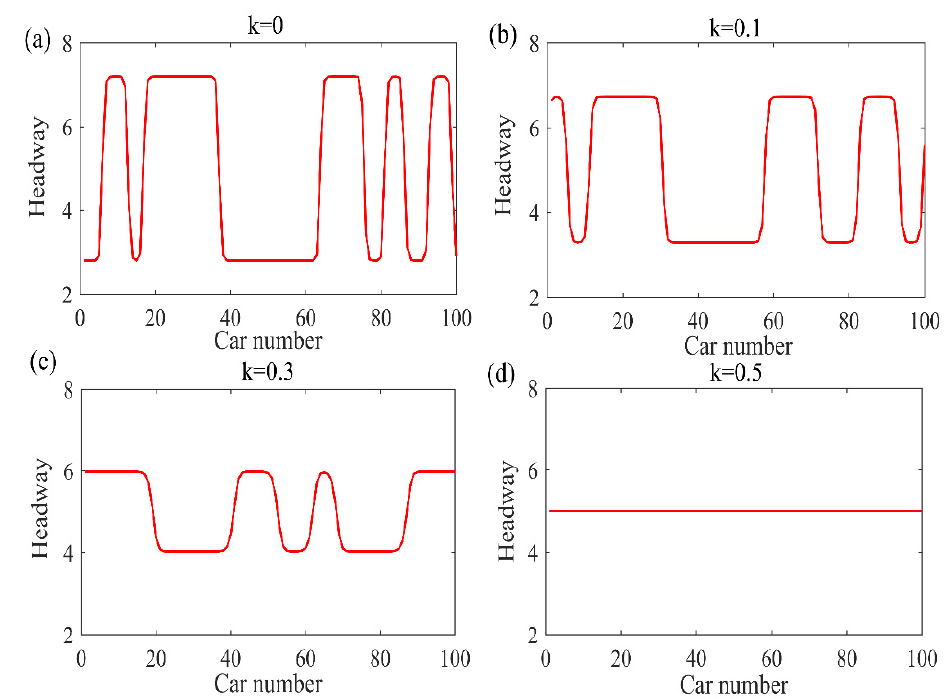
Figure 7. Profiles of the density wave at t = 15,000 corresponding to Figure 6, respectively.